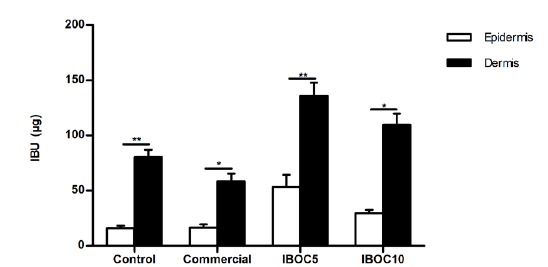
FIGURE 1 - Release of ibuprofen (IBU) over time - cumulative permeation curves of IBU from cream formulations containing 5 or 10% of copaiba oil in comparison to a control and commercial product. It represents the average of total IBU amount transferred by a diffusion area using pig ear skin as the membrane model monitored for 450 minutes (n=3).